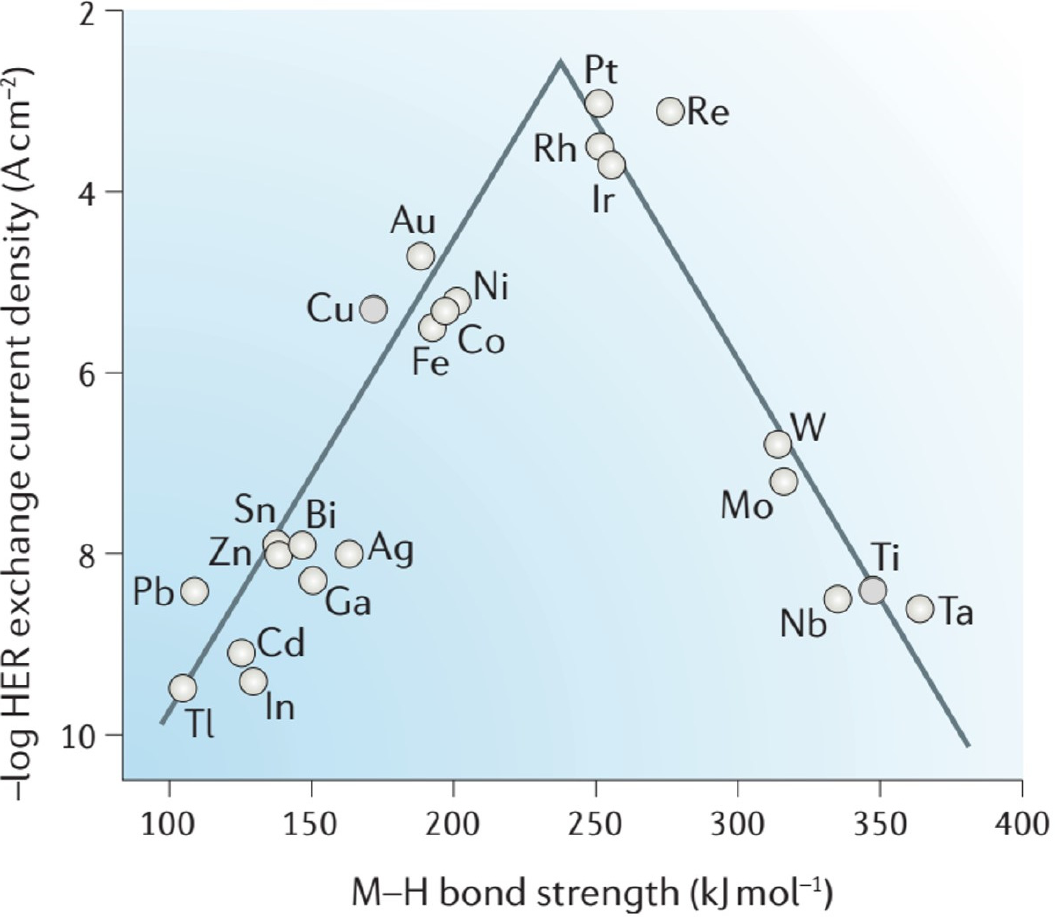
Figure 3. Trasatti’s volcano plot for hydrogen evolution reaction (HER). The plot shows the exchange current densities for HER versus the metal–hydrogen bond strength when H adsorbed on the electrode surface. Reprint from [81]. Copyright (2021), with permission from Elsevier.